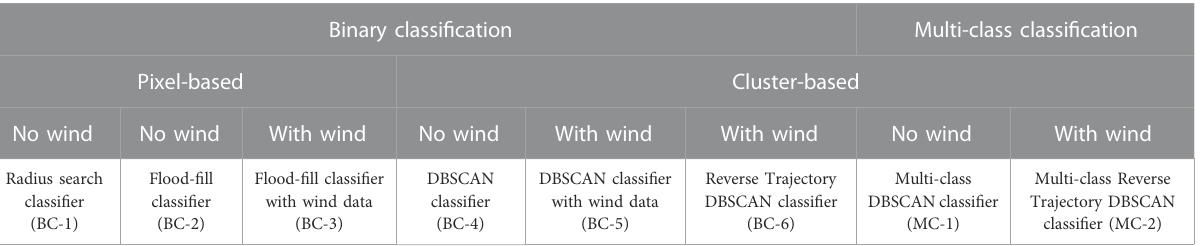
TABLE 1 Overview of all the tested